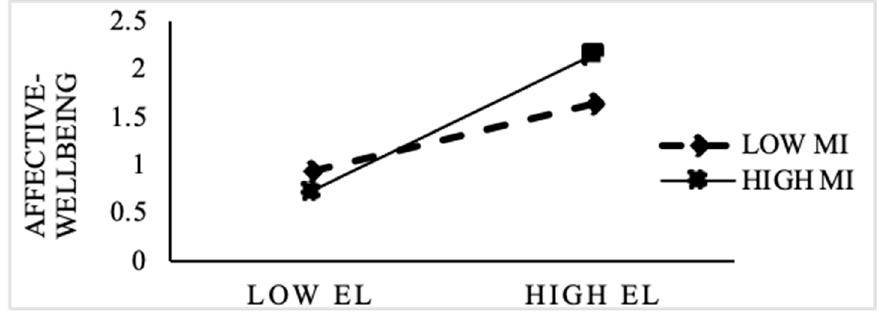
Figure 2. Moderation of moral identity.